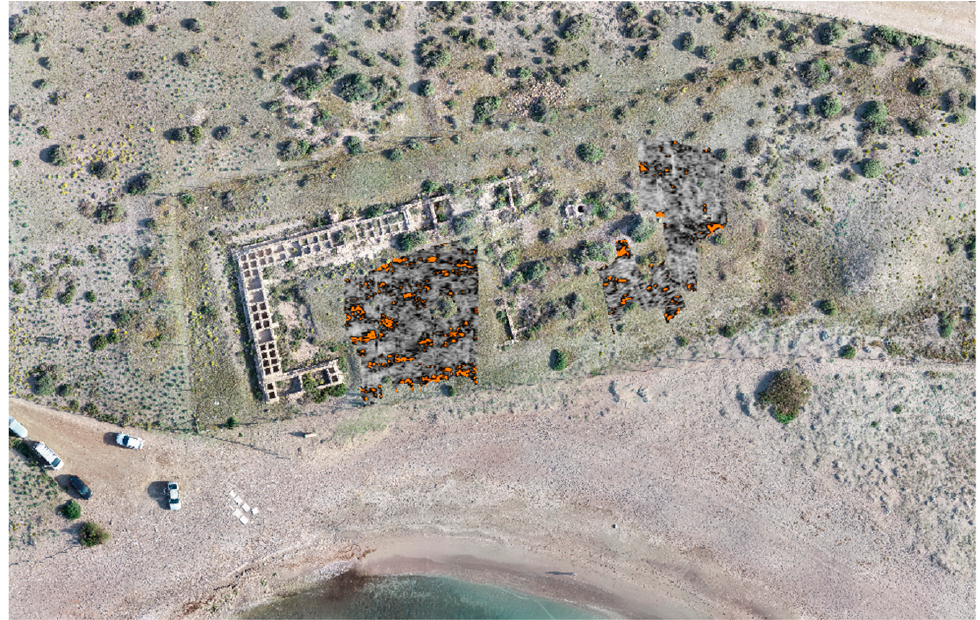
Figure 14. Mosaic GPR Projects 01-02-03.